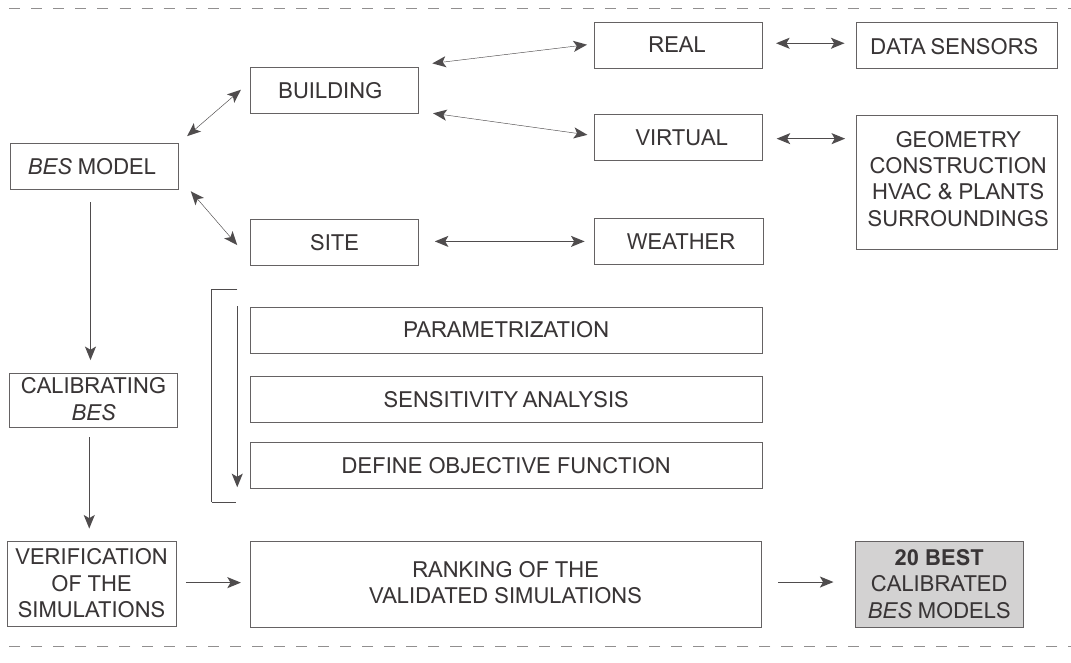
Figure 3. ZEC calibration methodology and model